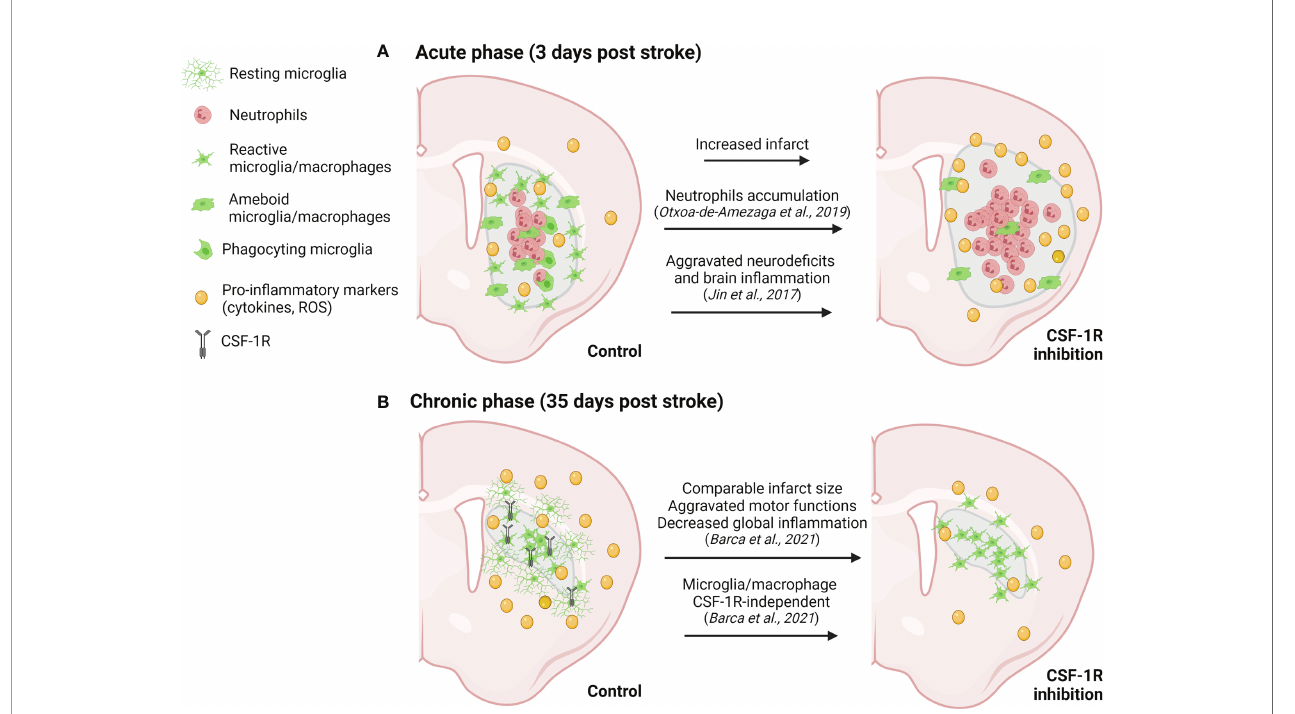
FIGURE 2 | CSF-1R inhibition monotherapy in stroke. (A) Previous studies on brain pre-conditioning reported the absence of microglial cells within the fi rst days post ischemia (acute phase) worsened disease outcomes, including increased brain injury, peripheral in fi ltration and pro-in fl ammatory signaling, ultimately leading to aggravated neurode fi cits. (B) Long-term treatment reveals the existence of an Iba-1 + (microglia/macrophages) cell population resistant to CSF-1R inhibition while global expression of in fl ammation-related markers was decreased. Long-term CSF-1R inhibition starting right after surgery led to aggravated motor functions, partly explained by homeostatic imbalance and impaired infarct reperfusion (88). Created with